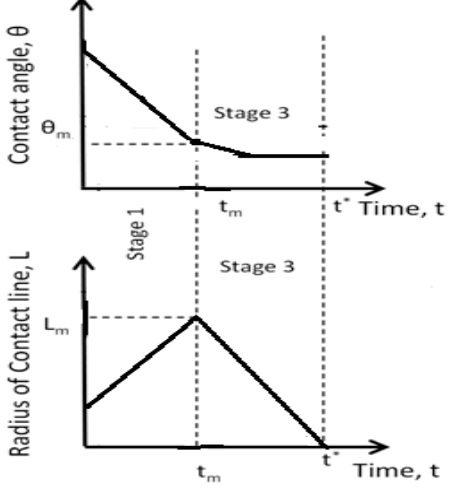
Figure 2. Two stages of spreading/imbibition of droplet over porous substrates in the case of complete wetting: L m is the maximum radius of droplet base, t m is the time when L m is reached, θ m is the contact angle at t m , t * is the time when complete imbibition is finished and θ f is the final contact angle at t * . Note, in the case of complete wetting stage 2 is absent (see Figure 1) [13].